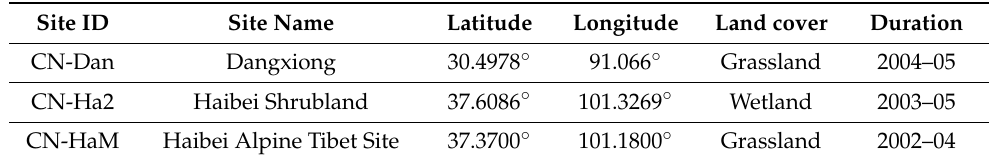
Table 1. FluxNet data summary. Tier one date of FluxNet2015 data set is used under the CC-BY-4.0 data usage license.